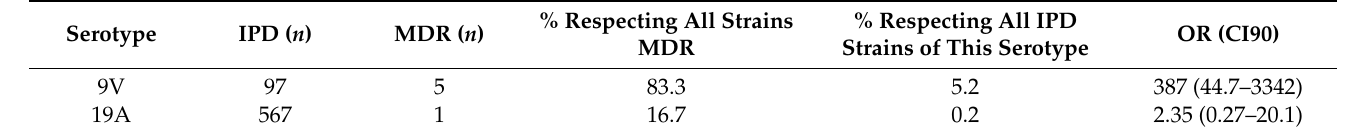
Table 2. Multidrug-resistant pneumococcal serotypes in the Madrid Region during the period 2007 to 2021.